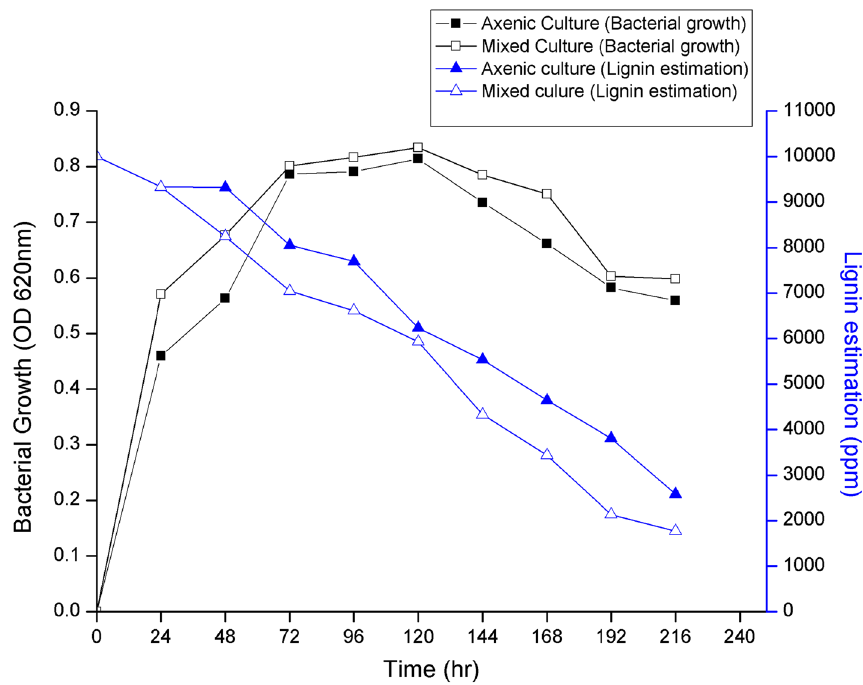
Fig. 4 Comparison of bacterial growth (620 nm) and lignin estimation (430 nm) in axenic and mixed culture, values are mean ± SE, n =